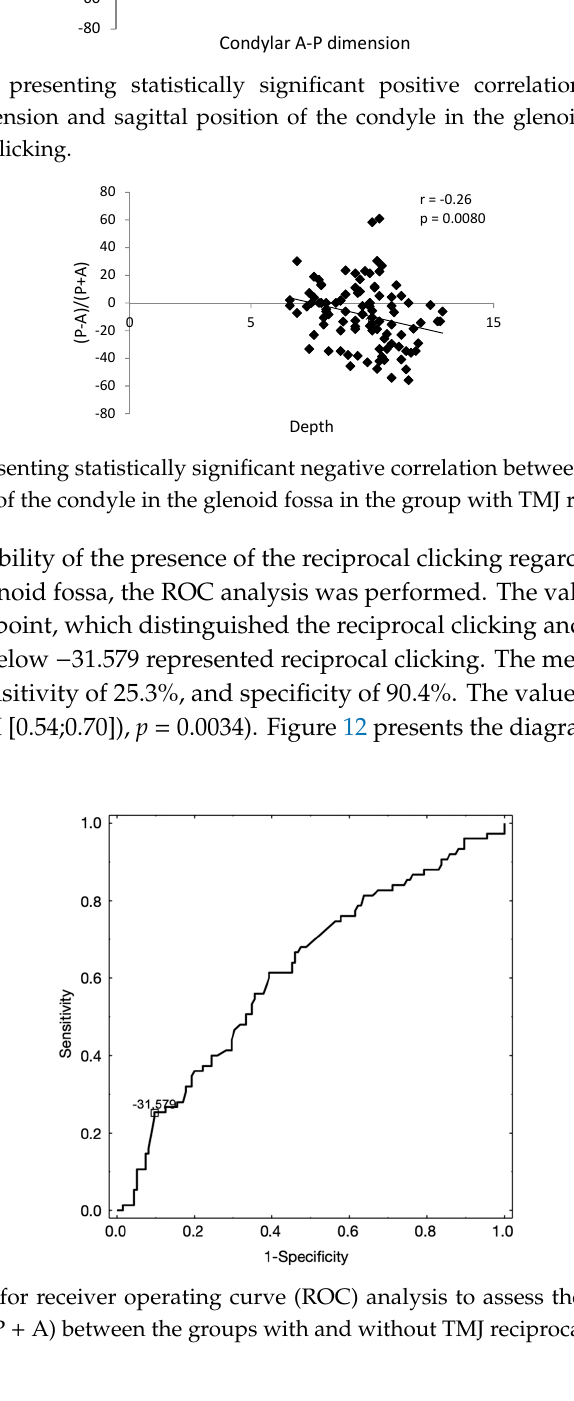
Figure 12. Diagram for receiver operating curve (ROC) analysis to assess the cut ‐ off value of the parameter (P − A) / (P + A) between the groups with and without TMJ reciprocal clicking.